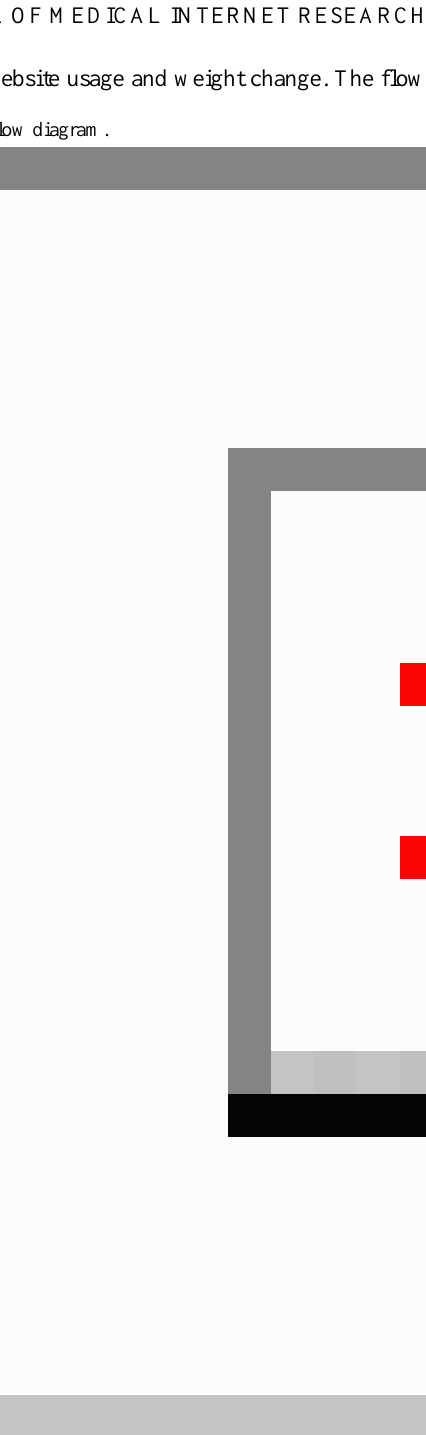
(Figure 1) depicts how the final cohort for analysis was defined.